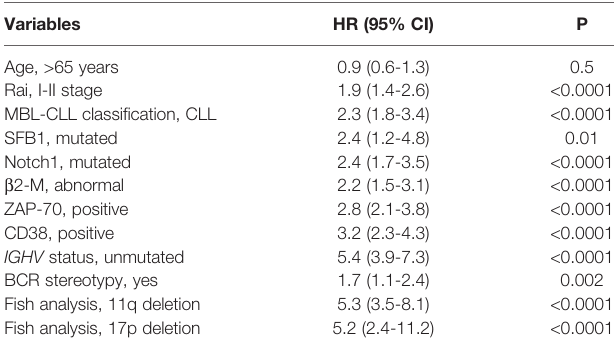
TABLE 1 | Cox univariate analyses of several variables that signi fi cantly predict TTFT in the training O-CLL cohort. Variables